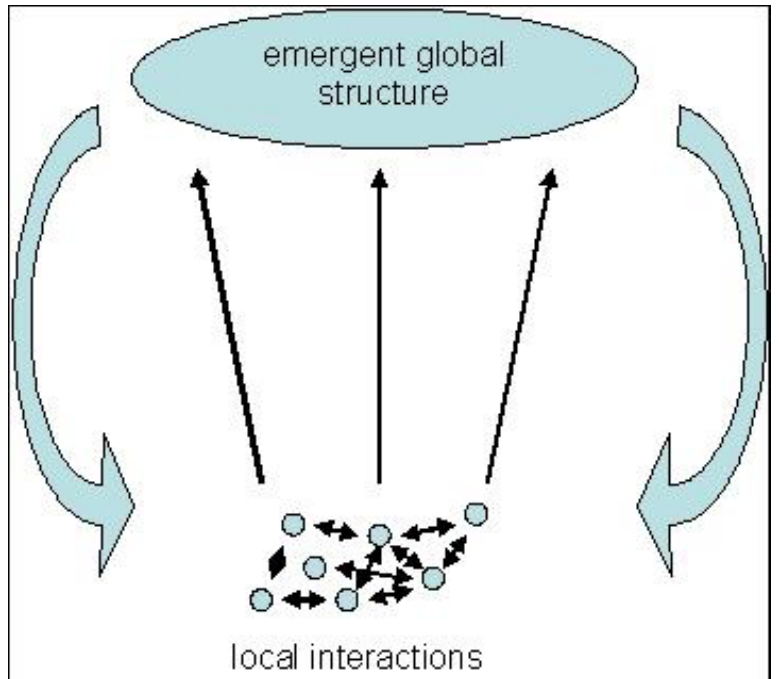
Figure 2. Abstract illustration of emergence in complex systems ([11], p.